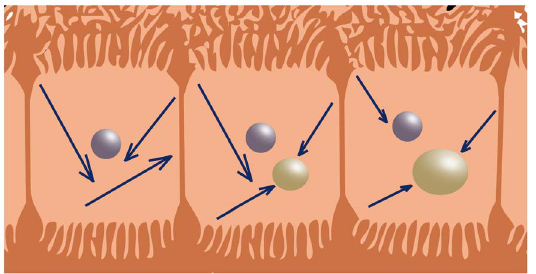
Figure 4. Schematic representation of the reduction of molecular diffusion in the hepatocytes by fat droplets. When fat is present in the liver, it is stored as triglycerides in sphere shaped vacuoles. Commonly, these (macrovesicular) vacuoles appear as just one large droplet (yellow spheres) with a diameter larger than 15 m m, sometimes dislocating the nucleus (purple spheres) with it. The mean diameter of a hepatocyte ranges between 20 and 40 m m. A considerable fraction of the volume of the hepatocyte can therefore be occupied by the macrovesicular fat droplet. Considering a diffusion length of about 17 m m, which is in the same order of magnitude of the hepatocyte’s diameter, the movement of water molecules (blue arrows) can be physically hindered by the presence of macrovesicular fat droplets in hepatocytes. This explains the decrease of the molecular diffusion with increasing hepatic fat fractions as a mechanical